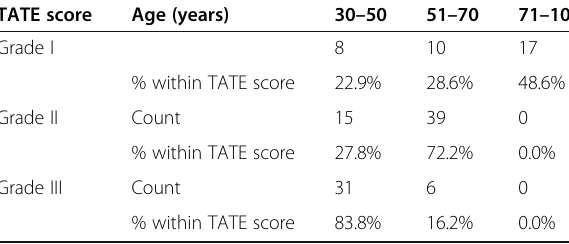
* P value 0.001, highly